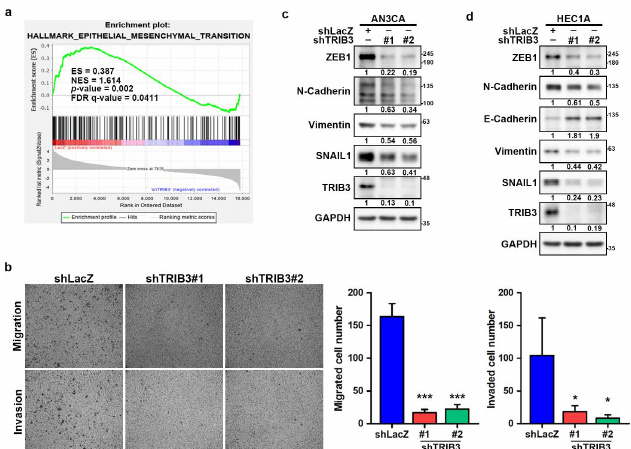
Figure 3. TRIB3 knockdown inhibited cell migration / invasion and suppressed the epithelial–mesenchymal transition (EMT)-related molecules of EC cells. ( a ) Gene set enrichment analysis (GSEA) of RNA-seq data identified an enrichment of EMT genes signatures in shLacZ control (red) vs. TRIB3-knockdown (blue) HEC1A cells. ( b ) AN3CA cells transduced with shLacZ or TRIB3-specific shRNAs carrying lentiviruses and selected with 2 µ g / mL puromycin for 3 days. Cell migration or invasion abilities were determined by transwell assay through seeding of 1 × 10 5 in the upper chamber. After incubation for 24 h, migrated and invaded cells were visualized ( left panel ) and counted ( right panel ) after staining with 0.1% crystal violet. Data are presented as the mean ± SD from three files of wells. * p < 0.05, and *** p < 0.001 when compared to shLacZ control. ( c , d ) AN3CA ( c ) or HEC1A ( d ) cells were transduced with shLacZ or TRIB3-specific shRNAs (#1 or #2) carrying lentiviruses and selected with 2 µ g / mL puromycin for 3 days. Specific amounts (25 µ g) of total cellular proteins were used for determination of indicated proteins by Western blot